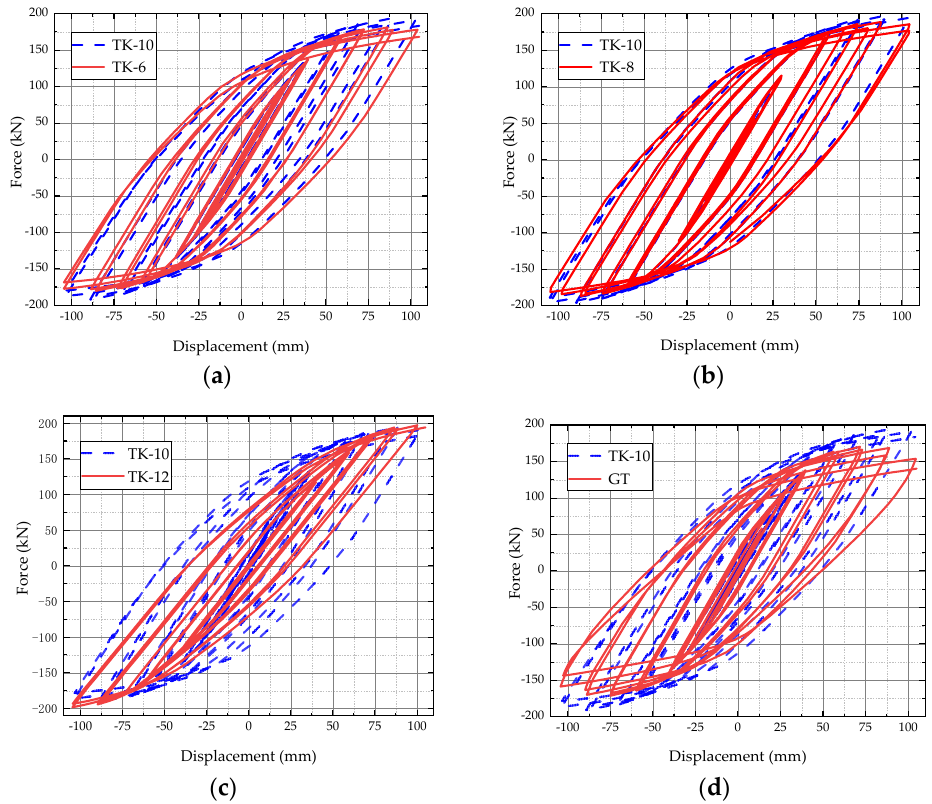
Figure 25. Hysteresis curve of FEM: ( a ) TK-6 and TK-10; ( b ) TK-8 and TK-10; ( c ) TK-10 and TK-12; ( d ) TK-10 and GT.